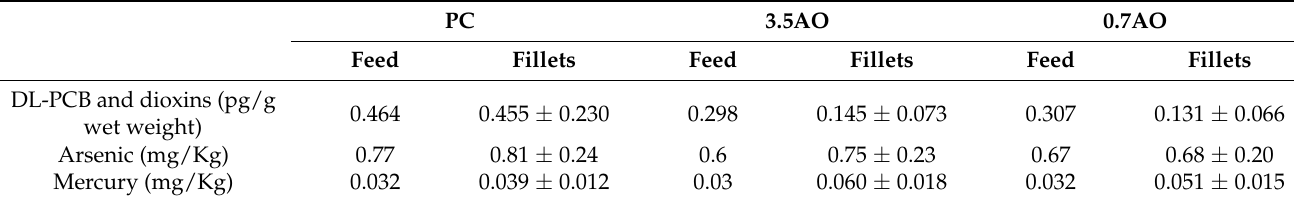
Table 4. Amount of heavy metals, dioxins, and dioxin-like polychlorinated biphenyls (DL-PCBs) found in feed and gilthead seabream